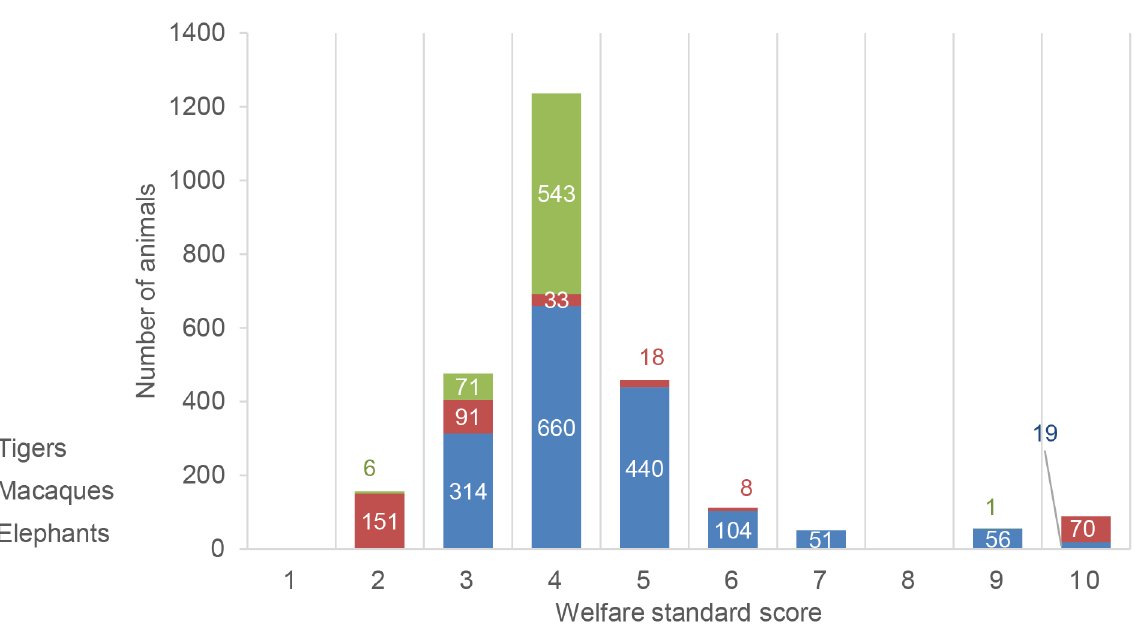
Fig 5. Distribution of animals according to their daytime welfare score (higher score = better welfare). The numbers of tigers, elephants and macaques were plotted according to the animal welfare score calculated by this study for the venues the animals were kept at. The figures largely correspond to the distribution of venues according to their welfare score. Most elephants and tigers are kept in conditions reflecting a score of 4, while the majority of macaques are kept at even lower quality venues with a score of 2.